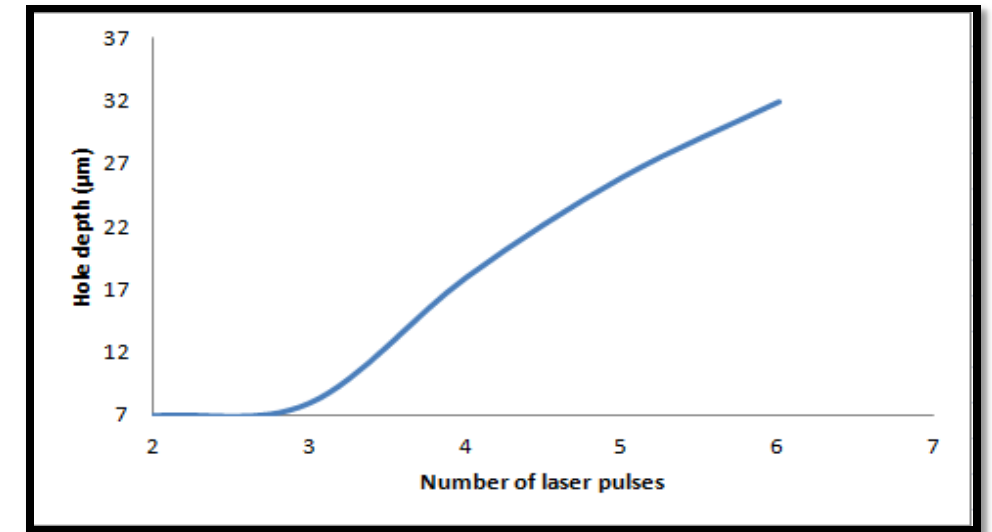
Fig.6: Hole depth against number of laser pulses in copper.